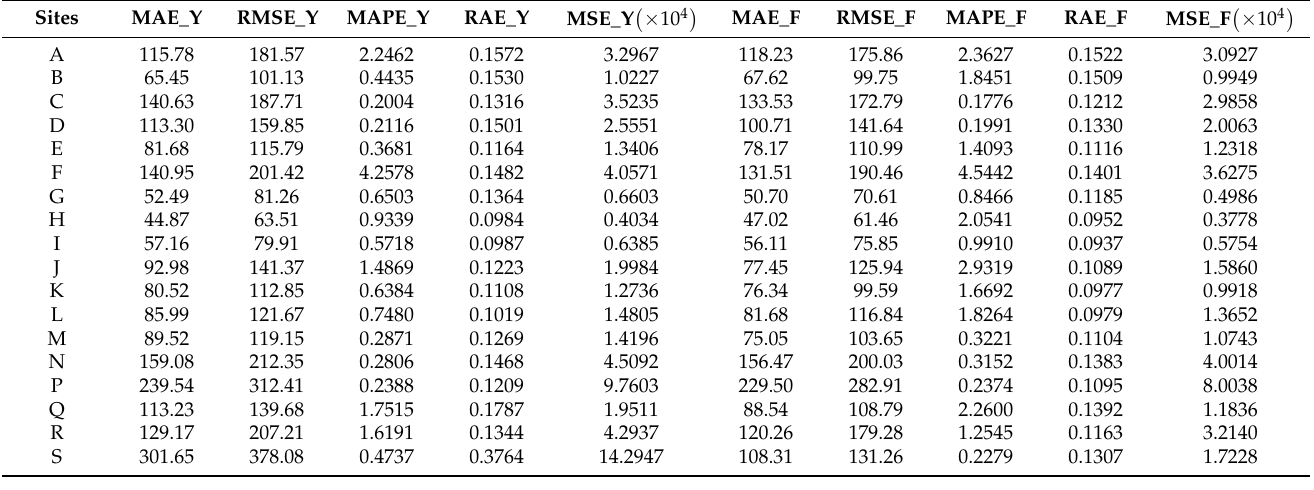
Table 11. Error analysis for the estimated normal distribution (Y) and the estimated fitness curve (F), where the first five columns describe the error in the PDF and the last five columns describe the errors in the fitness curve for the 8 GHz vertical polarization.